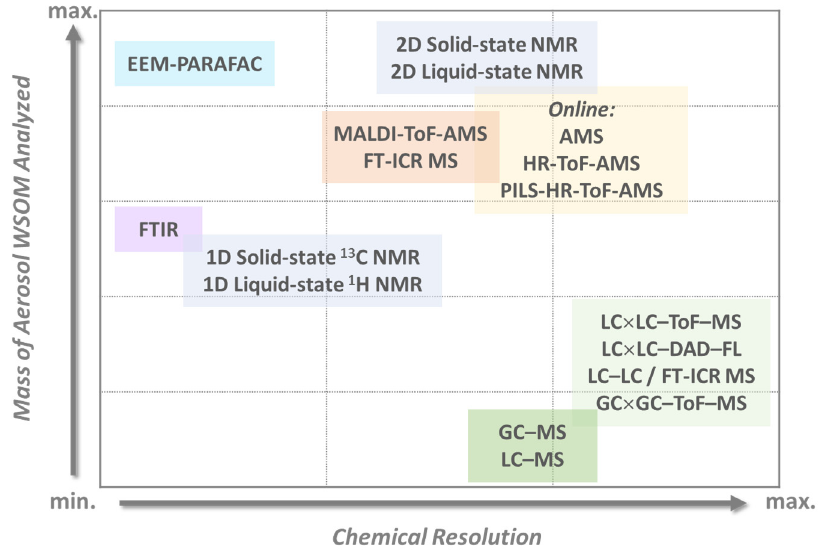
Figure 1. Schematic representation of the range of multidimensional analytical strategies currently employed in the characterization of aerosol WSOM as a function of the level of speciation and quantification achieved. Reprinted from the work of Duarte et al. [50], under the Creative Commons Attribution (CC BY) license. Acronyms: 1D: one-dimensional; 2D: two-dimensional; DAD: diode array detector; FL: fluorescence; EEM: excitation-emission matrix fluorescence spectroscopy; PARAFAC: parallel factor analysis; FTIR: Fourier transform infrared spectroscopy; NMR: nuclear magnetic resonance spectroscopy; MS: mass spectrometry; AMS: aerosol mass spectrometry; HR-ToF- AMS: high-resolution time-of-flight AMS; PILS: particle-into-liquid sampler; MALDI: matrix-assisted laser desorption/ionization; FT-ICR MS: Fourier transform–ion cyclotron resonance MS; GC-MS: gas chromatography-MS; LC-MS: liquid chromatography-MS; LC × LC: comprehensive 2D LC; LC-LC: heart-cutting 2D LC; GC × GC: comprehensive 2D